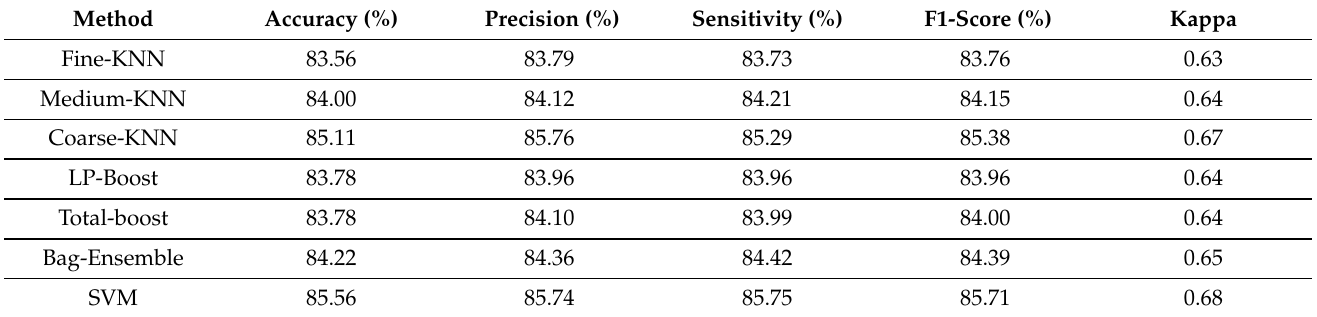
Table 12. Results obtained using different ML classifiers on 10-fold cross validation.